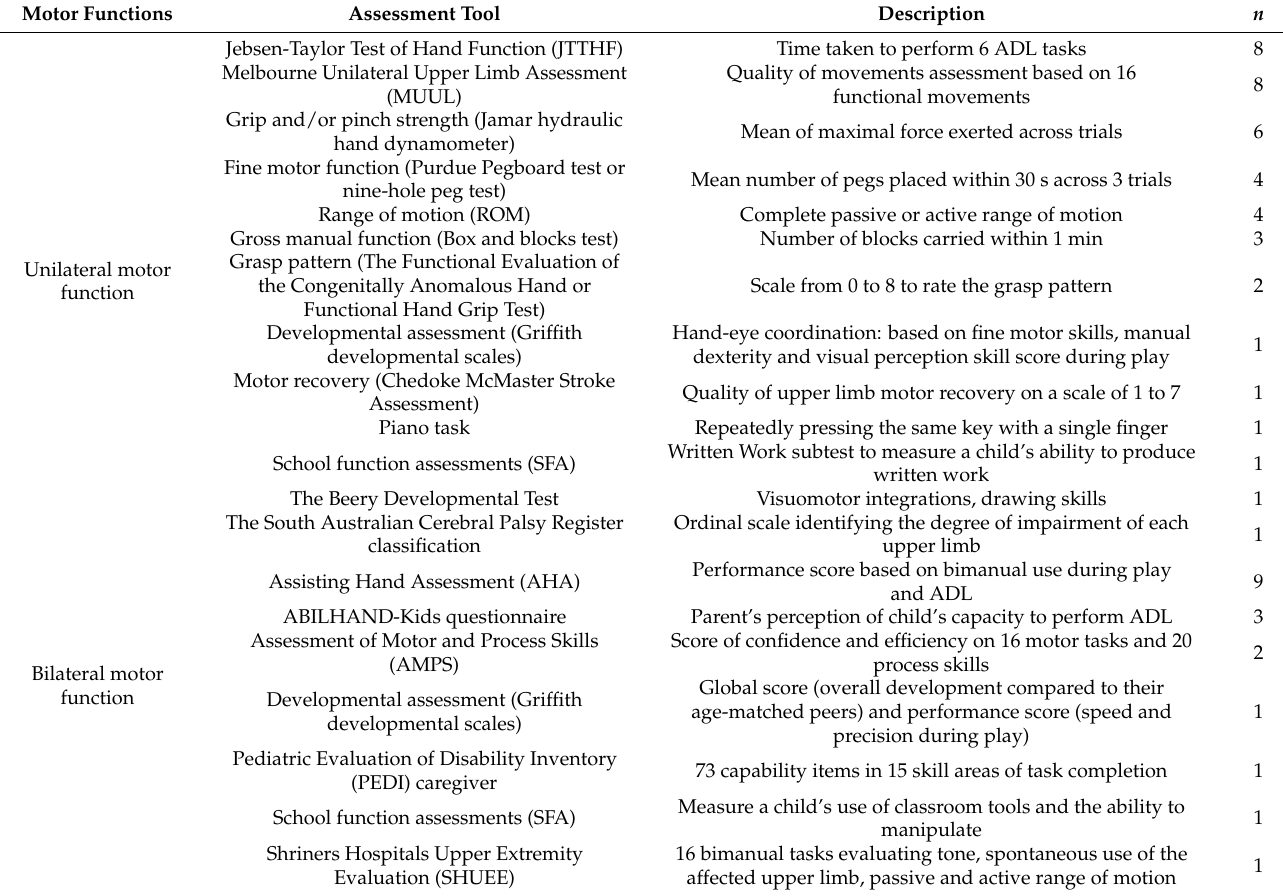
Table 1. Motor functions